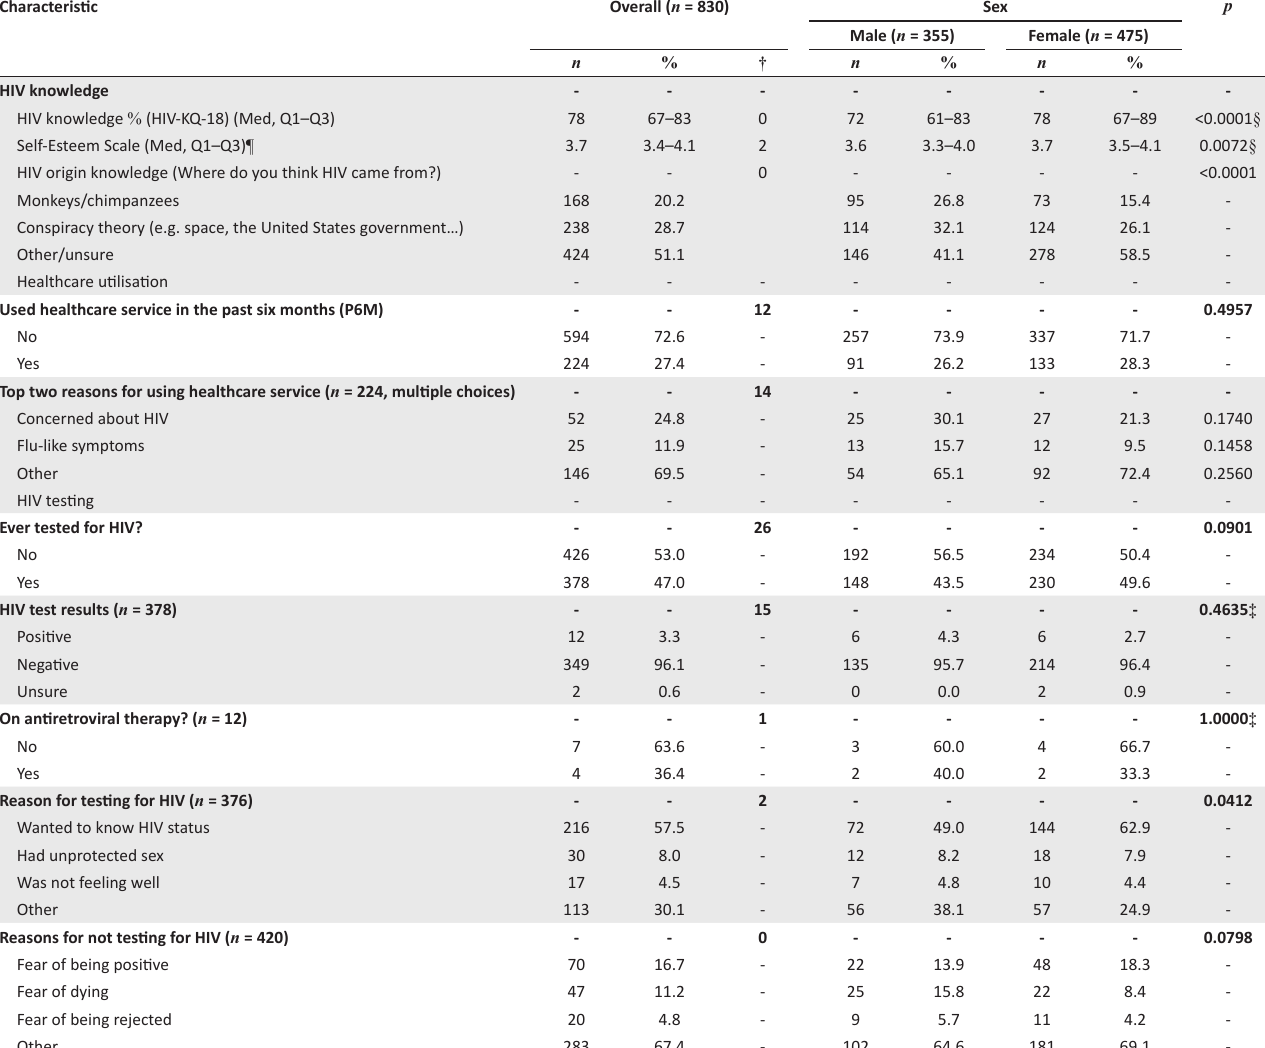
TABLE 2: HIV knowledge, self-esteem, health service and HIV–VCT counselling and testing utilisation among male and female Botsha Bophelo Adolescent Health Study participants ( N = 830).